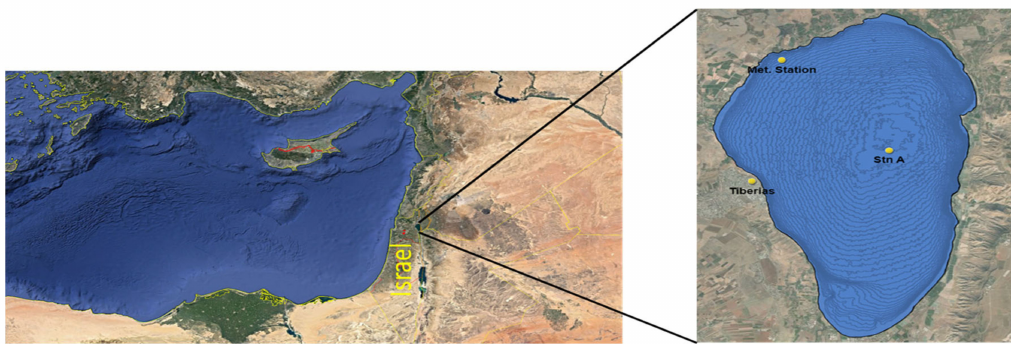
Figure 2. Map of the region and Lake Kinneret. The locations of Station A, the sampling station and meteorological station are marked on the map.